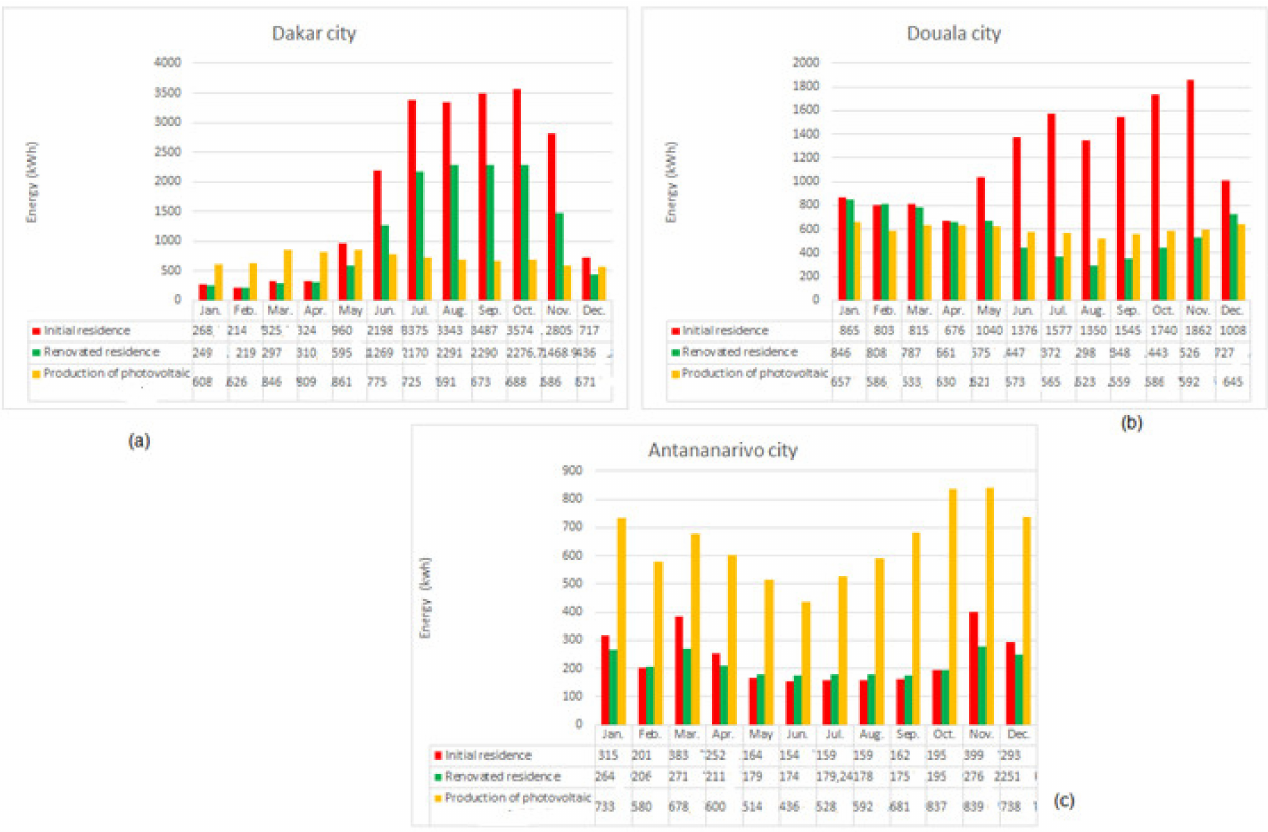
Figure 6. Monthly energy demand and production by photovoltaic panels in Dakar city ( a ); Douala ( b ); and Antananarivo ( c